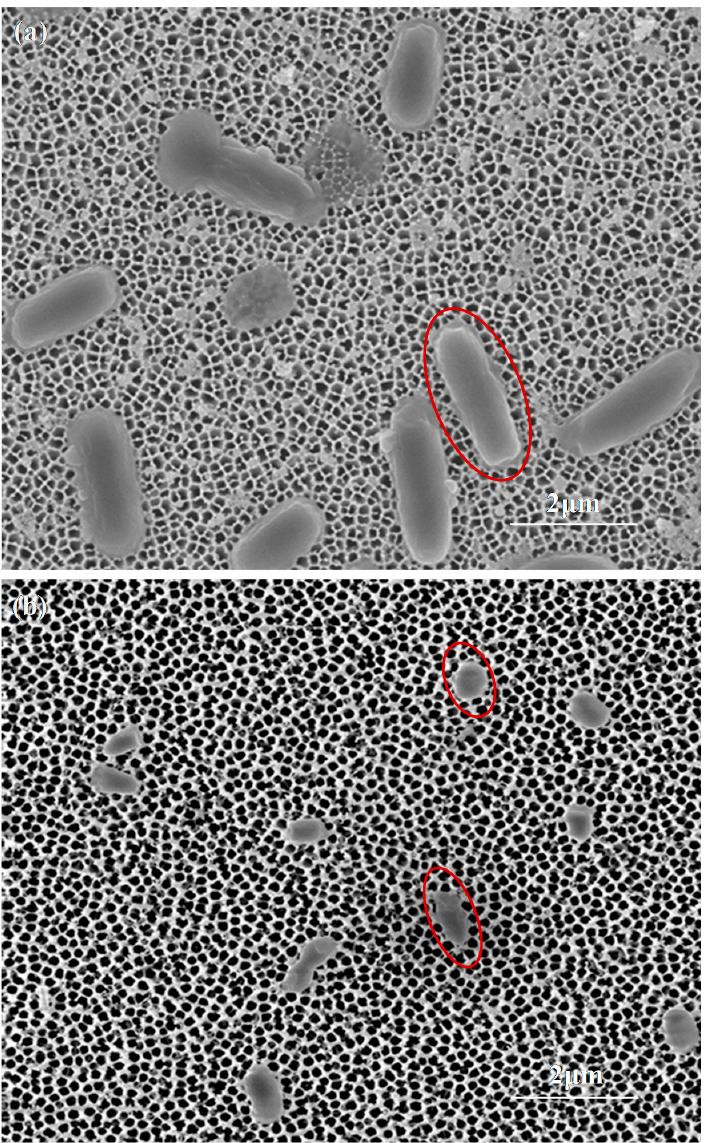
Figure 3. ( a ) SEM image of bacteria captured on nanoporous alumina membrane; ( b ) SEM image of bacteria after antibiotics treatment on nanoporous alumina membrane. The red ellipses indicated the shape change before and after antibiotics treatment.